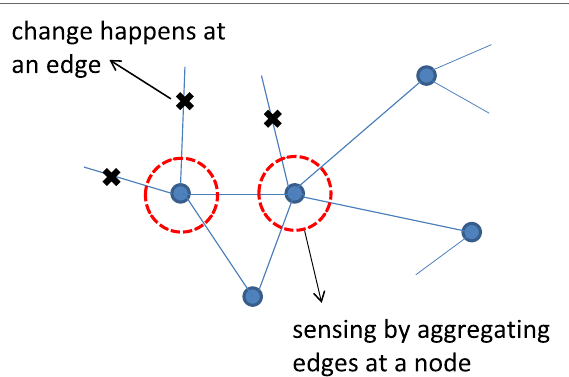
Fig. 13 Illustration of the measurement scheme for a power network. Suppose the physical quantities at edges (e.g., real power flow) at time i form the vector x i , we can observe the sum of the edge quantities at each node. When there is a power failure, some edges are affected, and their means are shifted